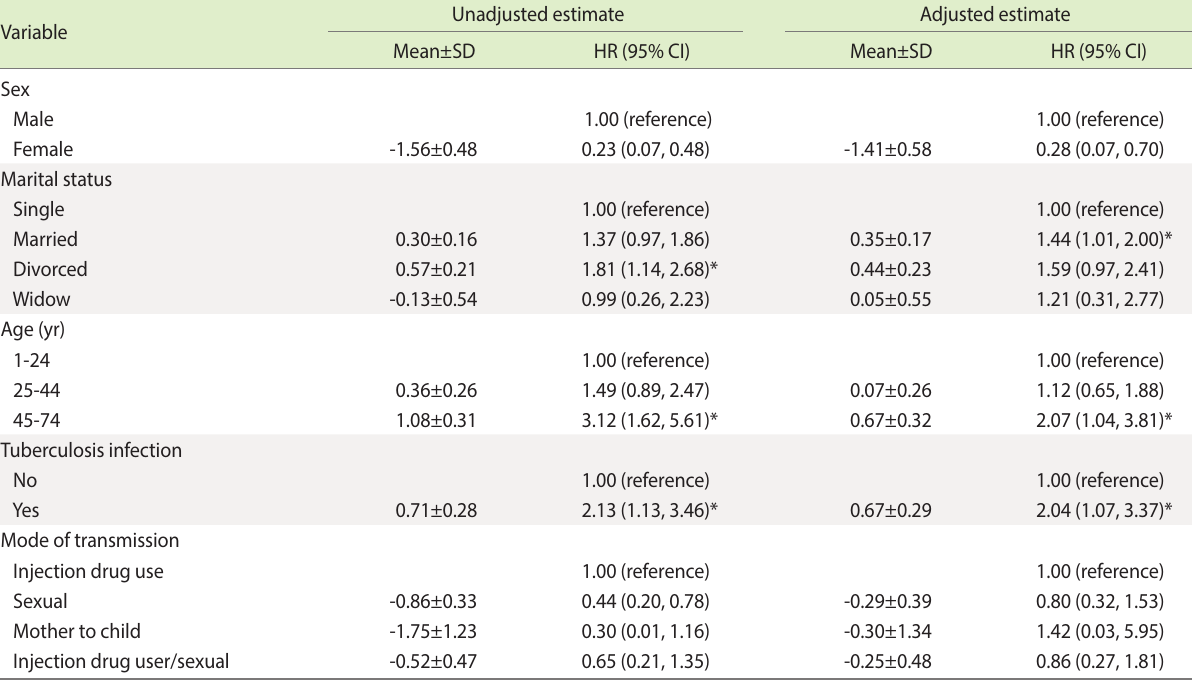
Table 2. Results of the spatial Weibull regression model for the risk of HIV/AIDS death in a cohort study in Hamadan, Iran (1997-2011)